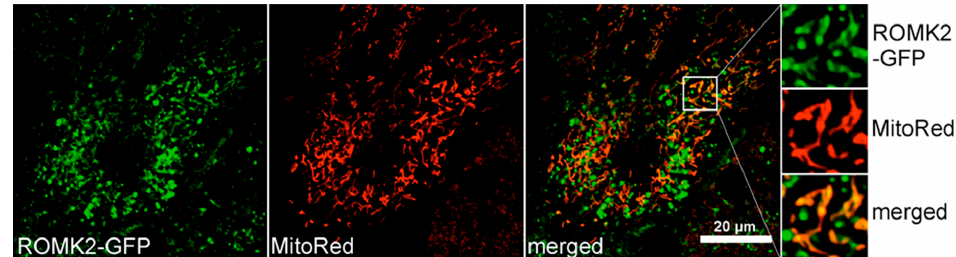
Figure 5. The localization of the ROMK2-GFP protein in H9c2 after transient transfection. Confocal images of the cultured H9c2 WT cells stained with MitoRed to detect mitochondria (red channel) and ROMK2-GFP (green channel). The superimposition of the two signals revealed the mitochondrial localization of the channel in H9c2 WT (orange). Part of the green signal was found to localize to other cellular compartments.